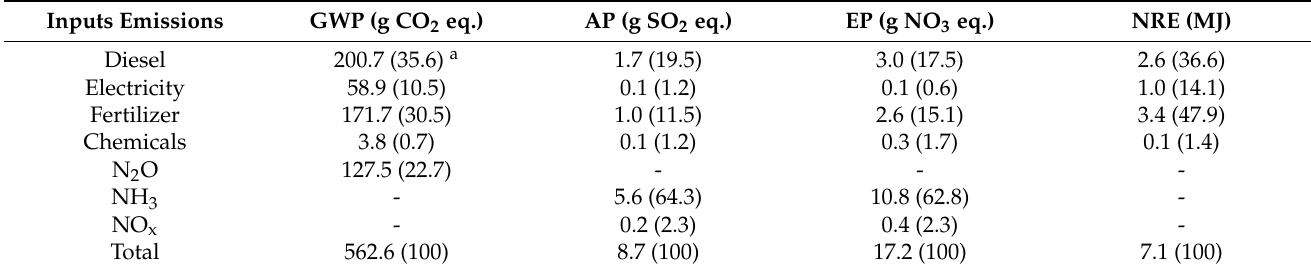
Table 1. Environmental characterization for the functional unit—1 kg of wheat harvested and deliv- ered to the flour mill—Global Warming Potential (GWP), Acidification Potential (AP), Eutrophication Potential (EP) and Non-Renewable Energy (NRE) use.